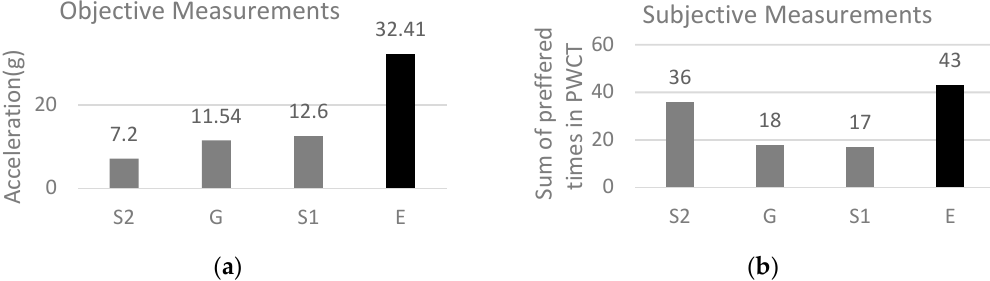
Figure 4. ( a ) Peak acceleration (g) determined for impactor measurements with the four insoles in the test; ( b ) Number of “better” cushioning comfort ratings over the other compared insoles (see last column of Table 2).